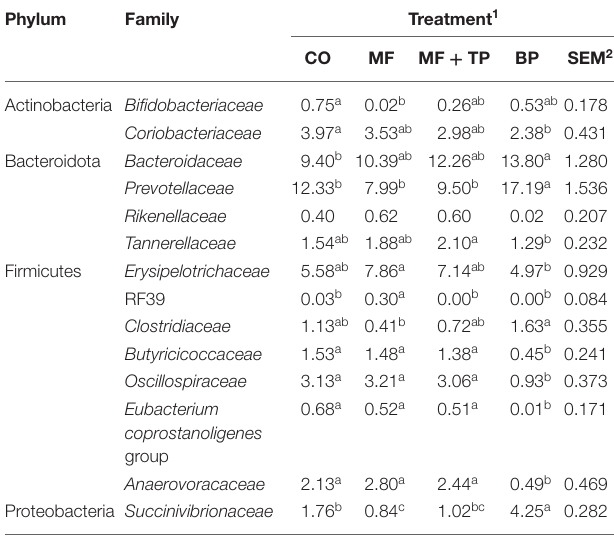
TABLE 5 | Fecal microbial composition (%) at the family level for cats fed treatments containing traditional and novel fiber sources.